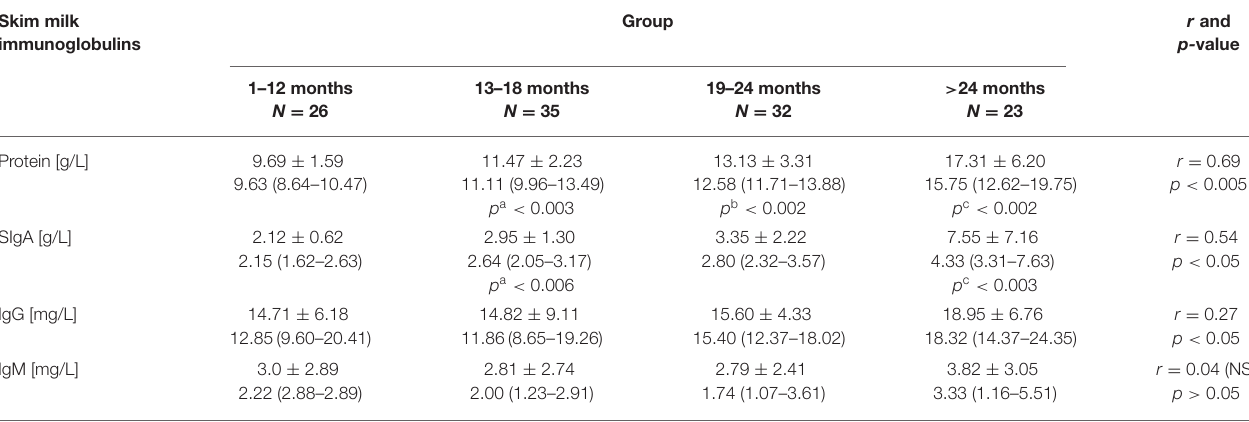
TABLE 2 | Concentration of protein and immunoglobulins in skim milk in prolonged lactation. Skim milk immunoglobulins